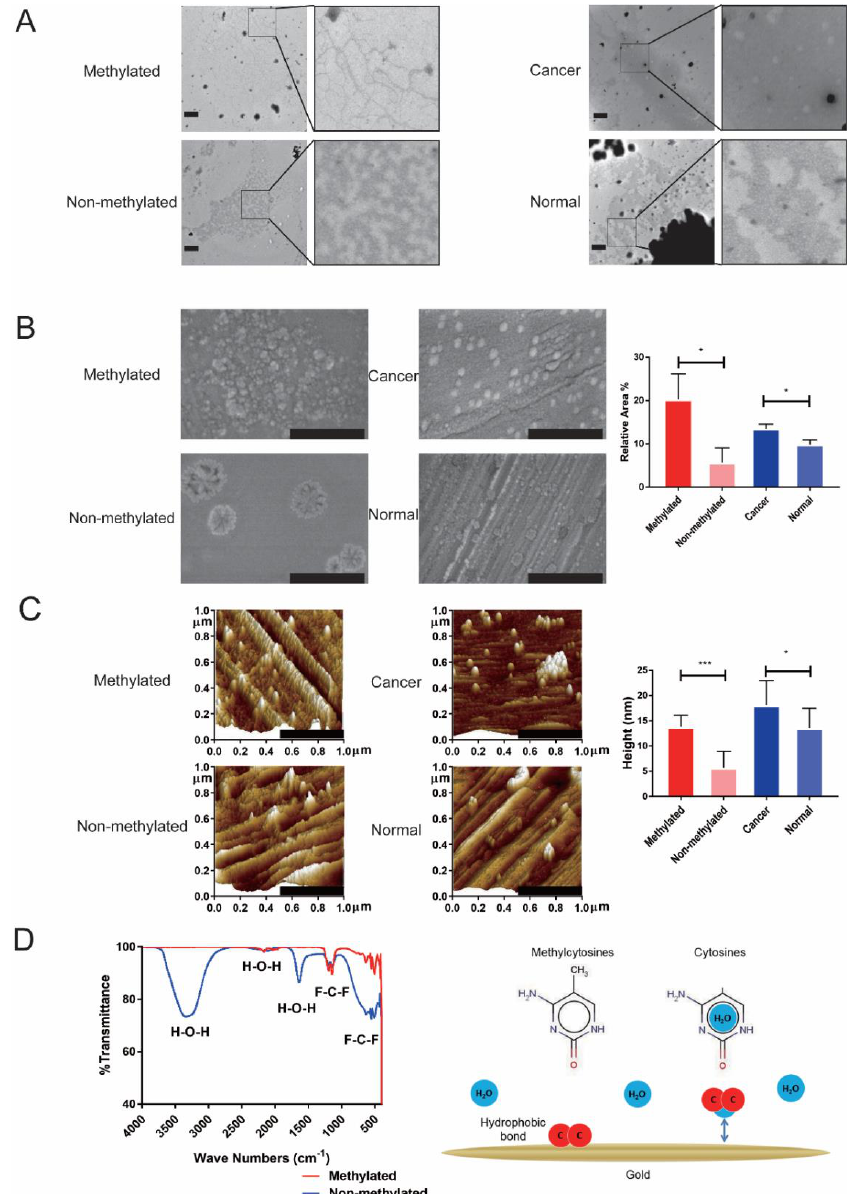
Figure 1. Methylation status affects the physical characteristics of DNA absorbed on a gold surface. ( A ) TEM images show methylated DNA and non-methylated DNA with different forms in a liquid environment. DNA from tumor tissue and normal tissue also show different forms (scale bar: 600 nm). ( B ) SEM images show methylated DNA has a larger adsorption area on the gold surface than non-methylated DNA. DNA from tumor tissue has a larger adsorption area on the gold surface than normal DNA (scale bar: 500 nm). ( C ) Atomic force microscope (AFM) images show methylated DNA has a higher adsorption cluster on the gold surface than non-methylated DNA. DNA from tumor tissue has a higher adsorption cluster on the gold surface than normal DNA (scale bar: 500 nm). ( D ) Left graph showed difference of binding groups between methylated DNA and non-methylated DNA adsorbed to gold surface by Fourier-transform infrared (FTIR). Right graph showed schematic of the potential mechanisms of differential adsorption capacity of methylated DNA and non-methylated DNA on the gold surface. * p < 0.05, *** p <